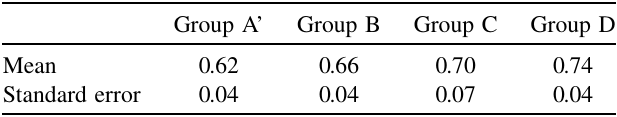
TABLE VIII. Average physics grades (normalized to 1) for post (3rd midterm) solutions for the different groups.